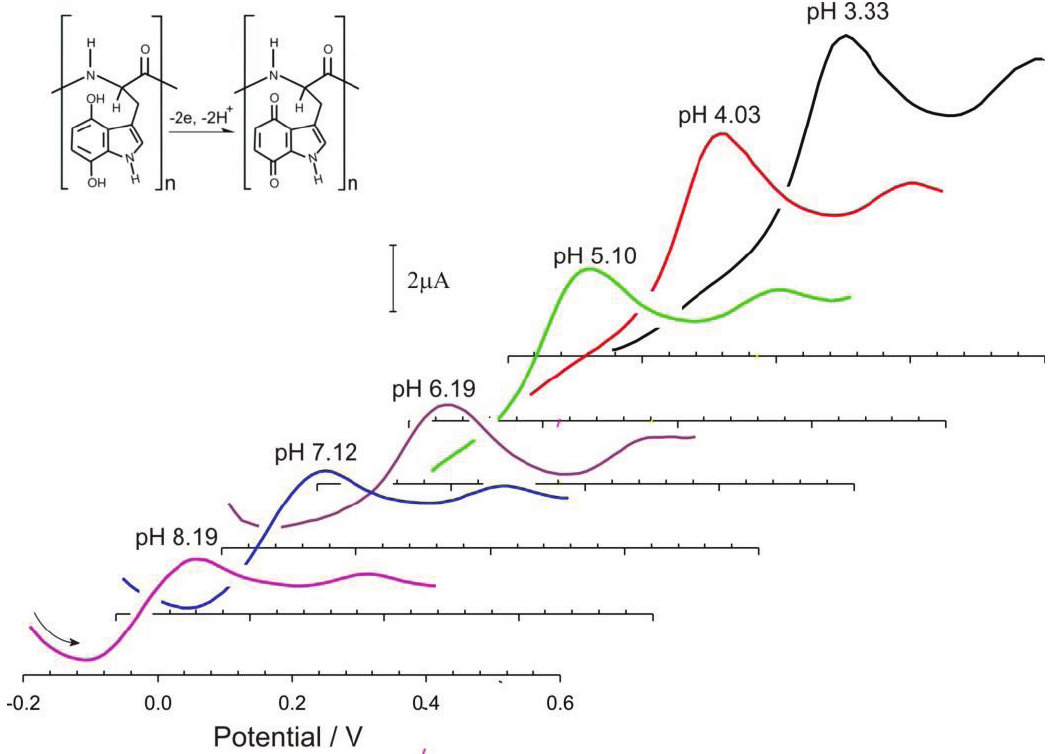
Figure 6. Square wave voltammograms detailing the influence of solution pH on the response of the poly-tryptophan — carbon fibre composite